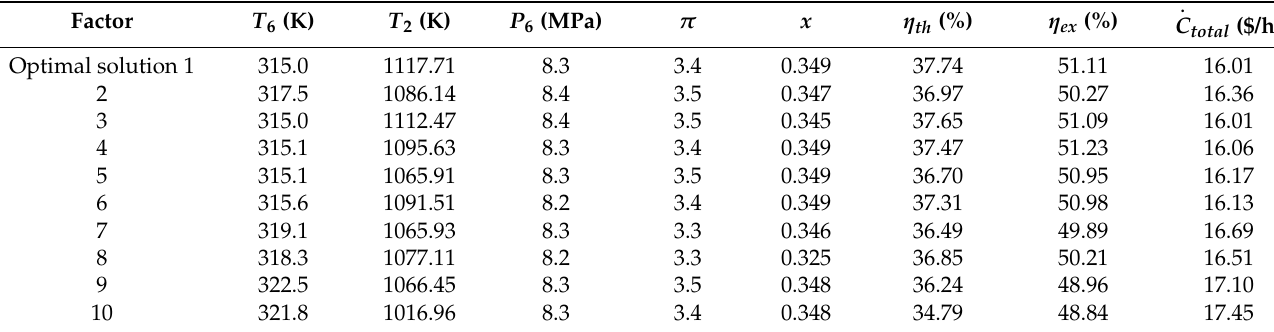
Table 7. Pareto optimal solution for η th , η ex , and C